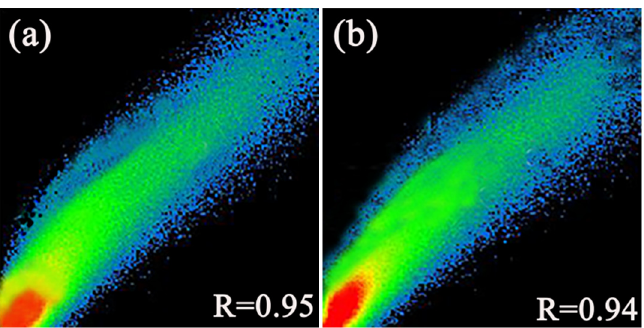
Figure 8. ( a ) R value of compound 1 and Mito Tracker Red ( b ) R value of compound 2 and Mito Tracker Red.